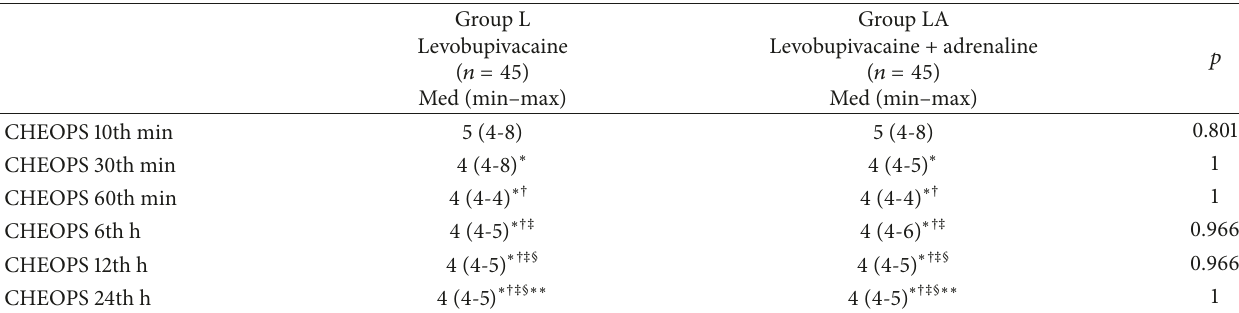
Table 2: The CHEOPS variables of three groups at each time interval after operation and values given are median (min–max). Group